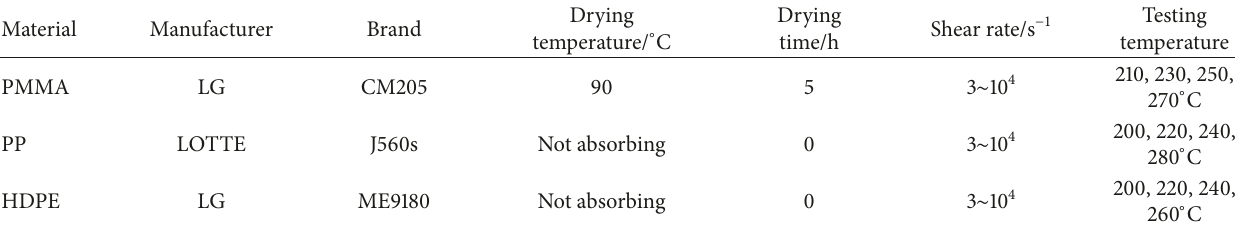
Table 1: Pretreatment and experimental parameters of the three